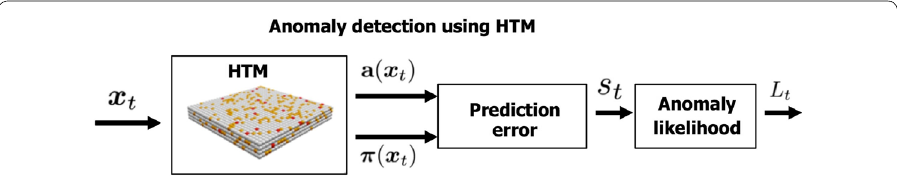
Fig. 4 Framework of HTM for anomaly detection [34, Fig 3(a)] Input vector (cid:31) x t of the data stream is sent to the HTM where it produces a sparse binary vector representing the current input, a ( (cid:31) x t ) and prediction for the next time step, (cid:31) π( (cid:31) x t ) . The prediction error, s t is calculated and is used to obtain the anomaly likelihood, L t . Image obtained under the Creative Commons license. No revisions were made to the